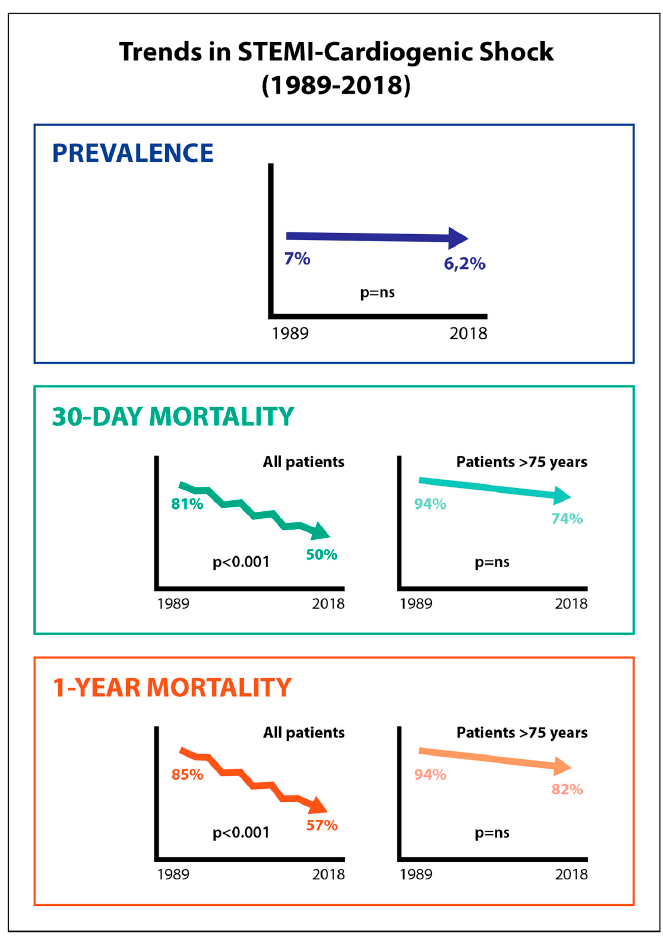
Figure 4. Summary Figure 4. Summary illustration.